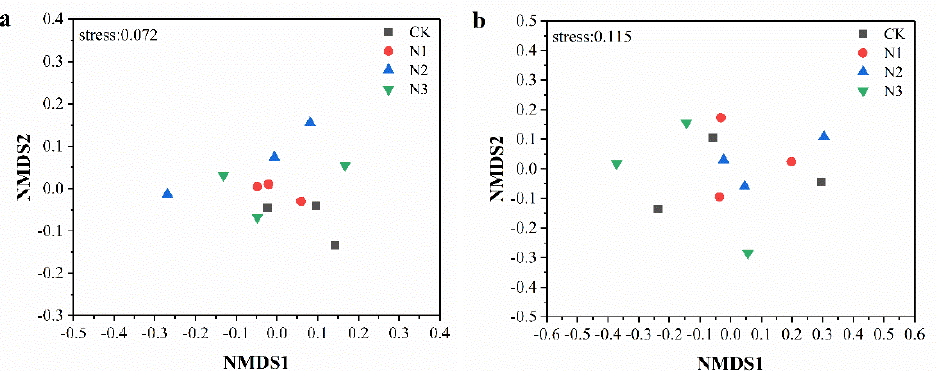
Figure 3. NMDS ordination based on Bray–Curtis similarities of ( a ) bacterial and ( b ) fungal communities under nitrogen addition. CK: 0 g N · m − 2 · year − 1 ; N1: 6 g N · m − 2 · year − 1 ; N2: 12 g N · m − 2 · year − 1 ; N3: 24 g N · m − 2 · year − 1 .